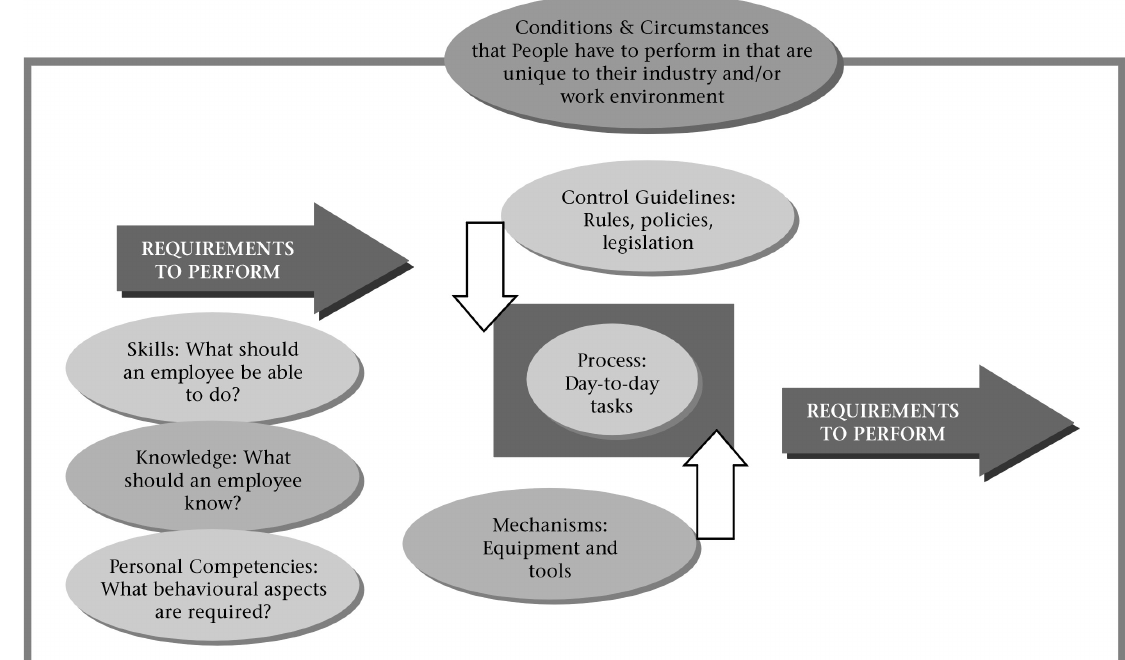
Figure1 Competency framework (©Chris Lombard,